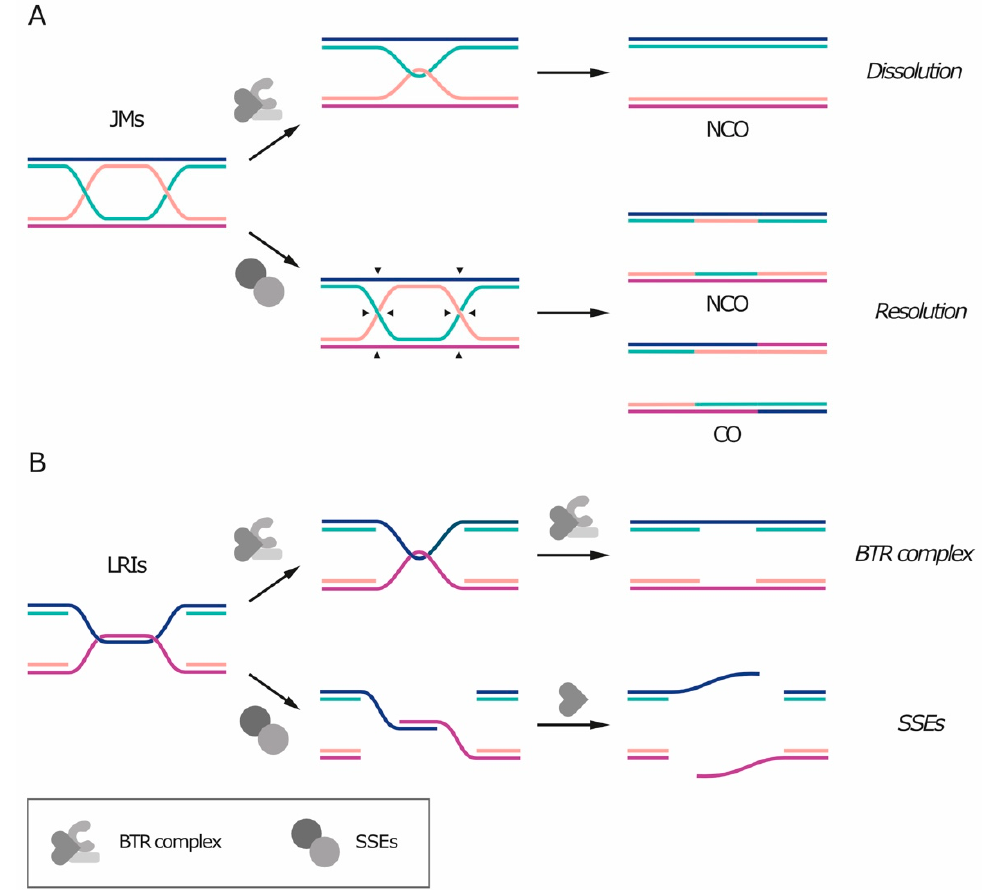
Figure 2. Joint molecules (JMs) and late replication intermediates (LRIs) can be disentangled by the BLM-TOP3A-RMI1 / 2 (BTR) complex or cleaved by structure-specific endonucleases (SSEs). ( A ) JMs can undergo BTR-mediated dissolution (top) or SSE-mediated resolution (bottom). Arrows indicate the possible sites of cleavage by nucleases. Dissolution always results in non-crossover products (NCO), whereas resolution can result in either crossover (CO) or non-crossover products. ( B ) LRIs can be processed by the BTR complex (top) or by structure-specific endonucleases (SSEs, bottom), leading to single-stranded DNA (ssDNA) gaps or ssDNA overhangs, respectively.